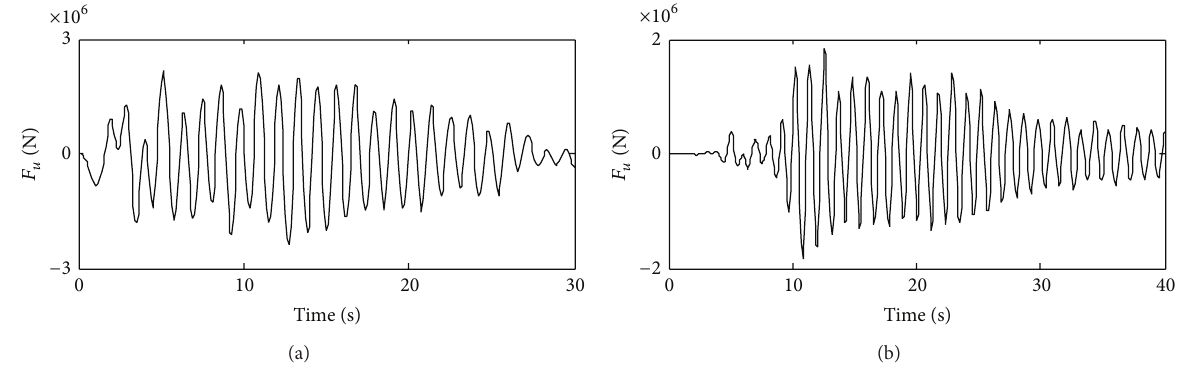
Figure 8: Time histories of the applied control forces for (a) El Centro and (b) Northridge earthquakes.